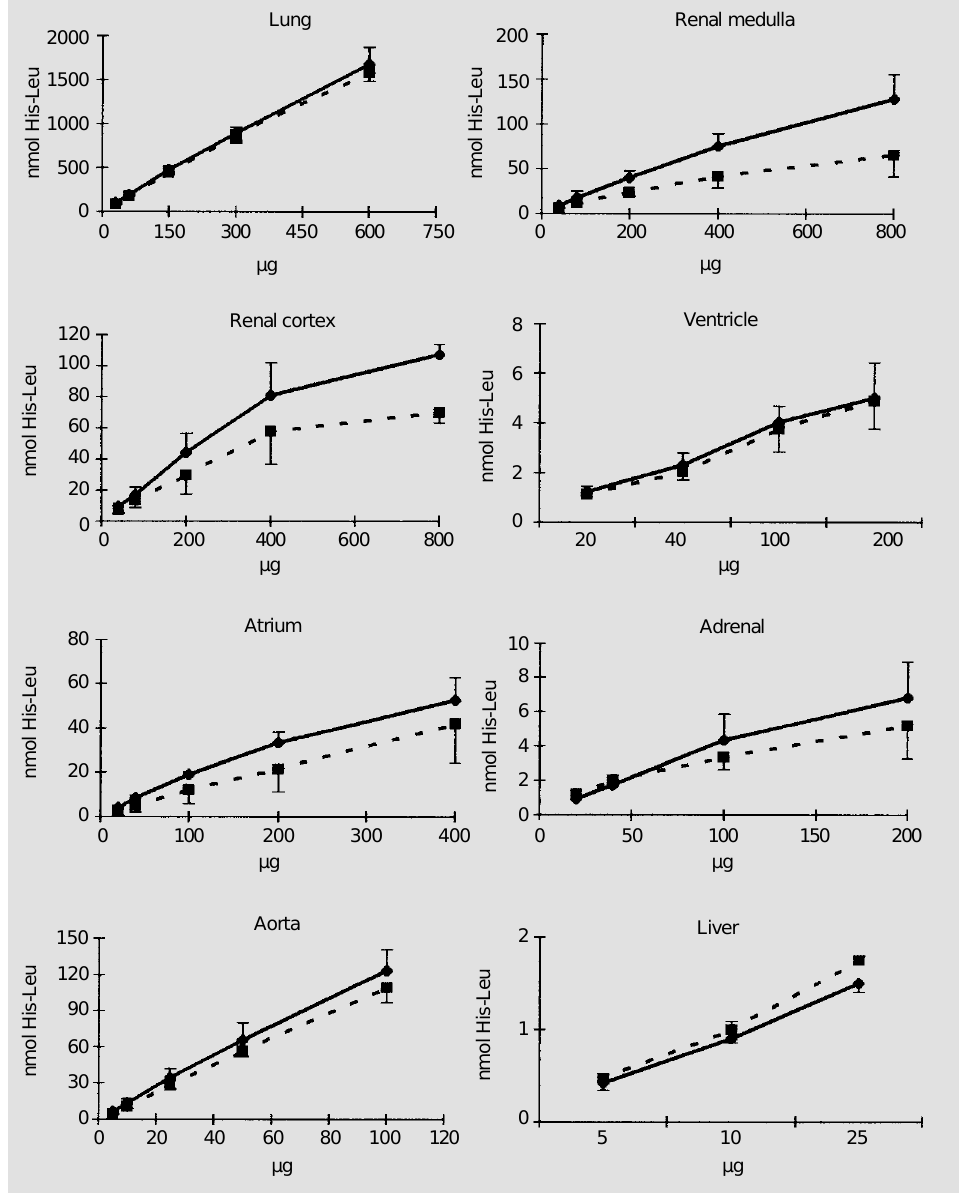
Figure 3 - Effect of protein con- centration in the assay medium on the formation of the His-Leu product by different tissue ho- mogenates. The assay was car- ried out for 15 min (lung, and renal cortex and medulla) or 30 min (other tissues) as described in Material and Methods. Data are reported as the mean ± SD of three independent experi- ments for SHR (squares) and Wistar (lozenges)